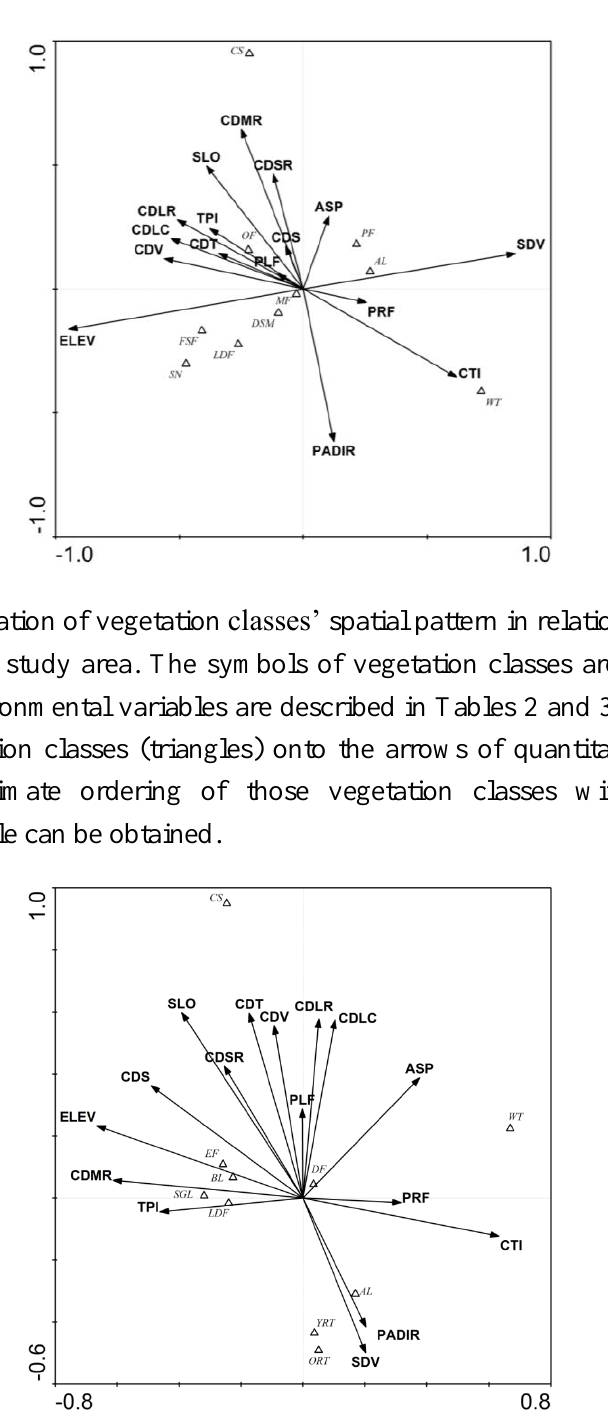
Figure 4. CCA ordination of vegetation classes’ spatial pattern in relation to environmental variables in the northern study area. The symbols of vegetation classes are listed in Table 4. The symbols of environmental variables are described in Tables 2 and 3. By projecting the points of the vegetation classes (triangles) onto the arrows of quantitative environmental variable, an approximate ordering of those vegetation classes with respect to that environmental variable can be obtained.